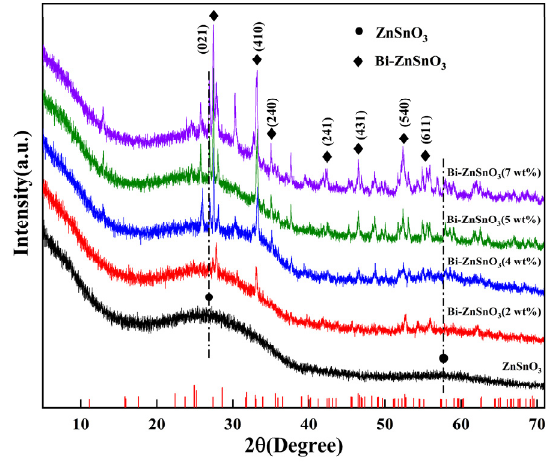
Figure 2. XRD patterns of ZnSnO 3 and Bi-ZnSnO 3 .